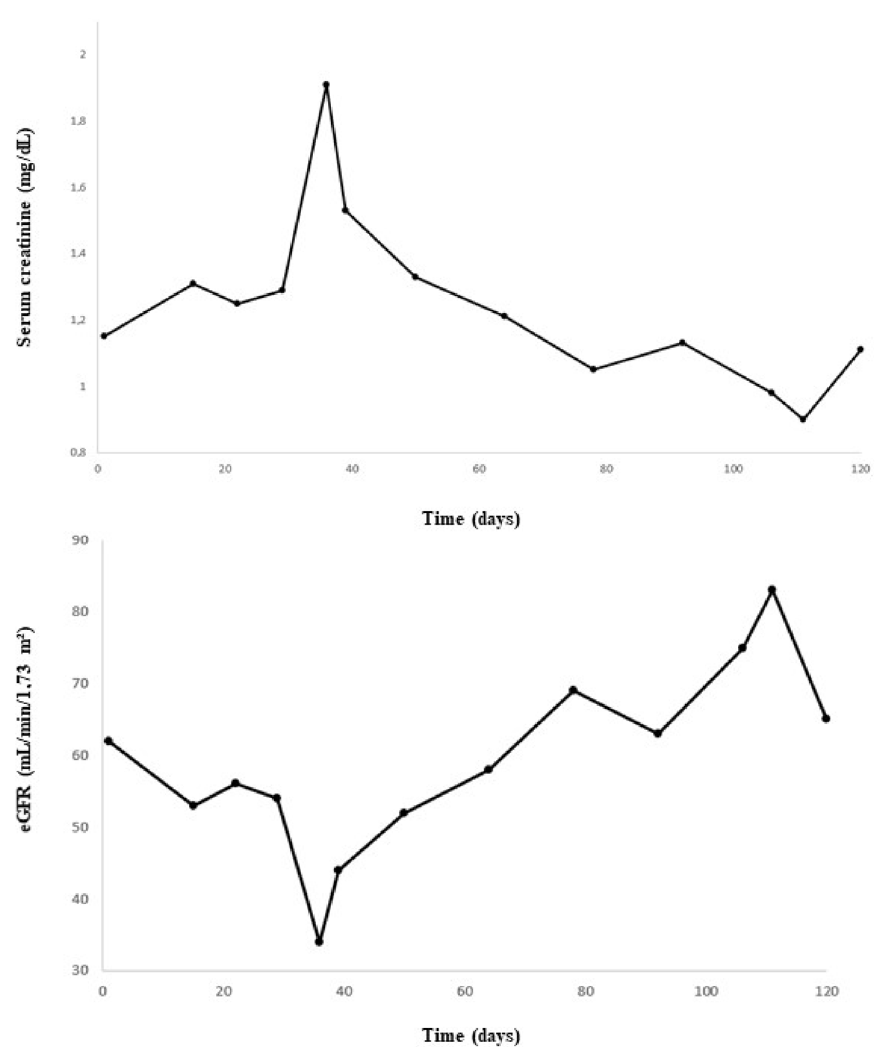
Figure 1. Evolution of serum creatinine and estimated glomerular filtration rate (eGFR) over time.